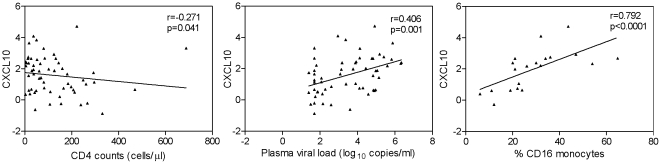
Relationships between plasma CXCL10 levels and CD4 count, plasma viral load, and frequency of CD16+ monocytes.Plasma CXCL10 levels show positive correlation with plasma viral load and frequency of CD16+ monocytes, and negative correlation with CD4 counts. Data was analyzed by Spearman correlation, with p<0.05 considered significant.